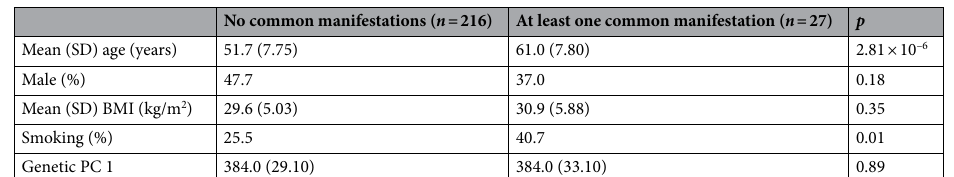
Table 2. Characteristics of V122I carriers with ≥ 1 diagnosis of a common hATTR amyloidosis manifestation (polyneuropathy, carpal tunnel syndrome, cardiomyopathy, and heart failure).